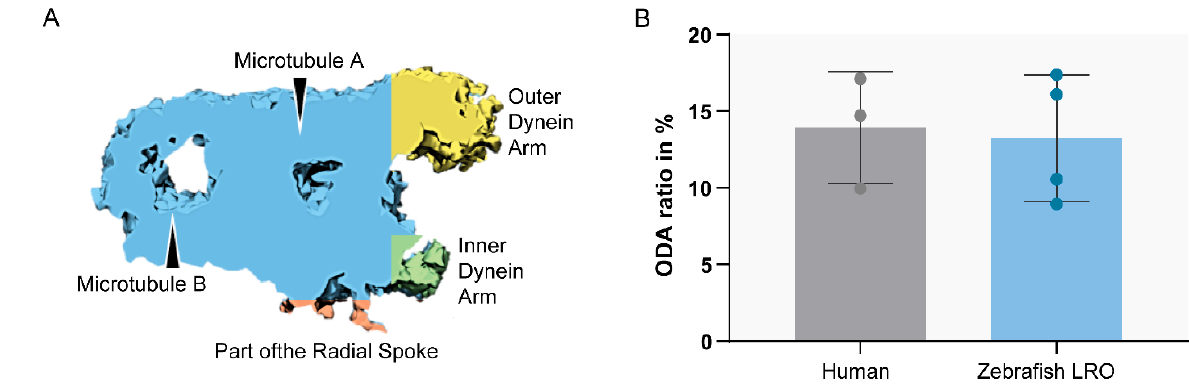
Figure 6. Ratio between ODA and MTD volume. Sub-tomographic averaging of the MTD of WT zebrafish cilia, showing ODA and IDA, tubules ( A , B ) and a portion of the radial spoke. The two sample groups were not significantly different (P > 0.05, Student’s t-test). N=3 human patients and n=4 zebrafish LROs.